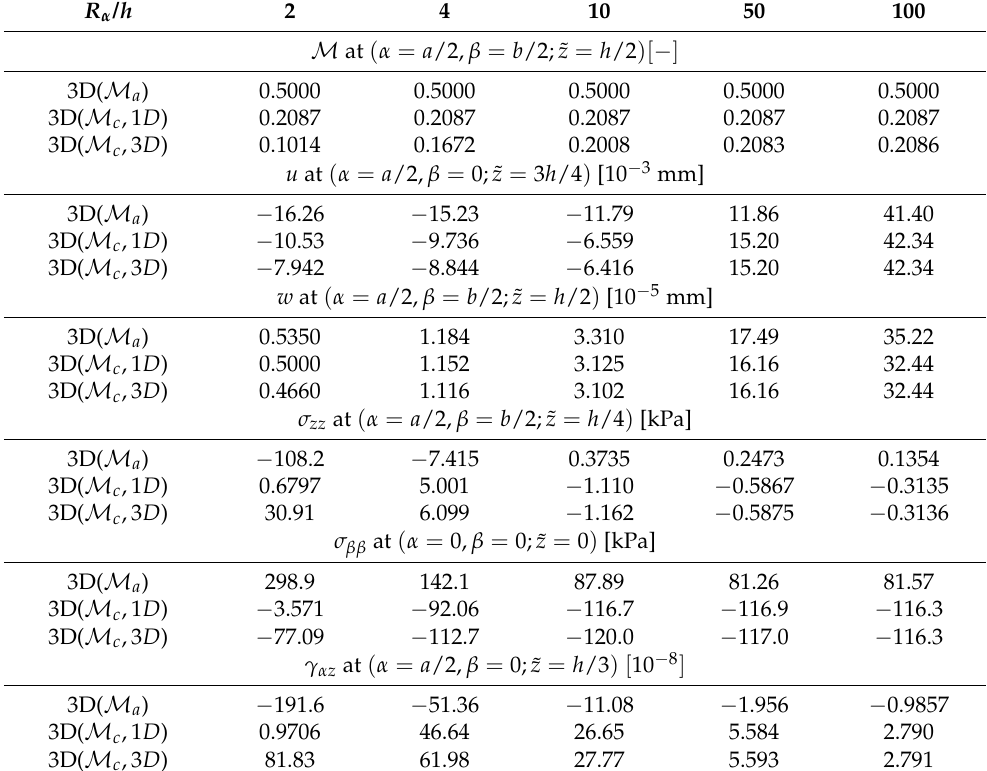
Table 7. Third benchmark: cylindrical sandwich shell panel with an FGM core subject to an external moisture content applied to the top and bottom surfaces. The results of all the 3D models consider N = 3 and NL =